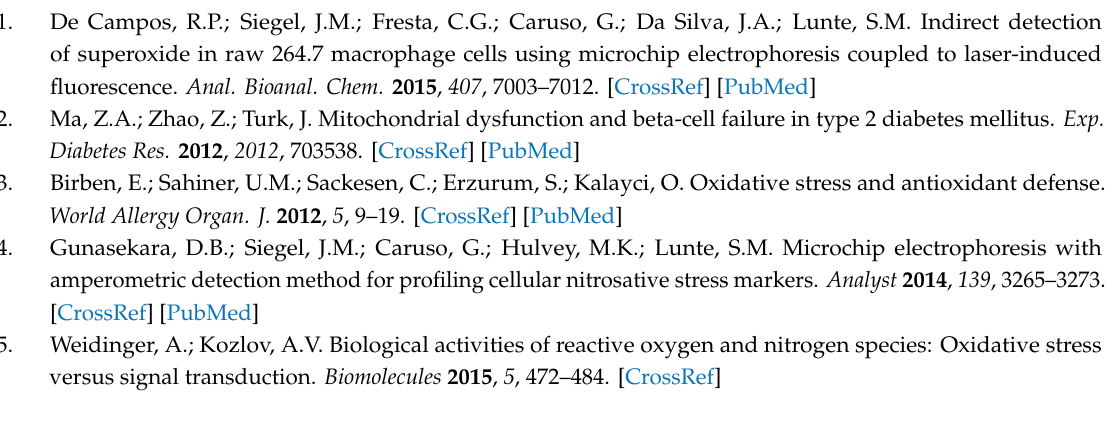
Figure S1: Experimental procedure for the determination of O 2 − • levels in RAW 264.7 macrophages using microchip electrophoresis with laser-induced fluorescence (ME-LIF) and MitoSOX Red probe; Figure S2: Representative immunoblots of (A) total Nrf2, (B) nuclear Nrf2, and (C) HO-1 in protein extracts from resting (control) macrophages and macrophages stimulated with PMA and SOD inhibitors, in absence or presence of increasing concentrations (5, 10, or 20) of carnosine. Histograms refer to the means ± SD of three independent experiments. The densitometric values of total Nrf2 and HO-1 bands were normalized against GAPDH. The densitometric values of nuclear Nrf2 were normalized against Histone